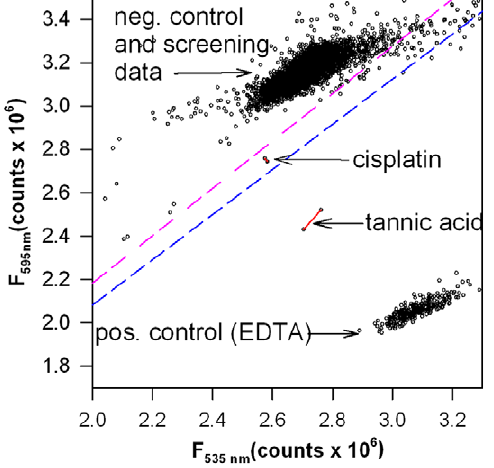
Figure 4. Results from screening a small library of known bioactives. Scatter plot of screening data for a small library of known bioactive small molecules using the PA-CMG2 screening assay. The pink dashed line shows the arbitrary cutoff representing inhibition greater than 3 standard deviations from the plate mean; a blue dashed line showing 5 standard deviations from the plate mean has also been drawn for comparison. Arrows point to compounds with inhibition values larger than the cutoff for both wells (red lines connect duplicate wells). Compounds that cluster in the top right hand corner have significant compound autofluorescence and were not considered potential hits.